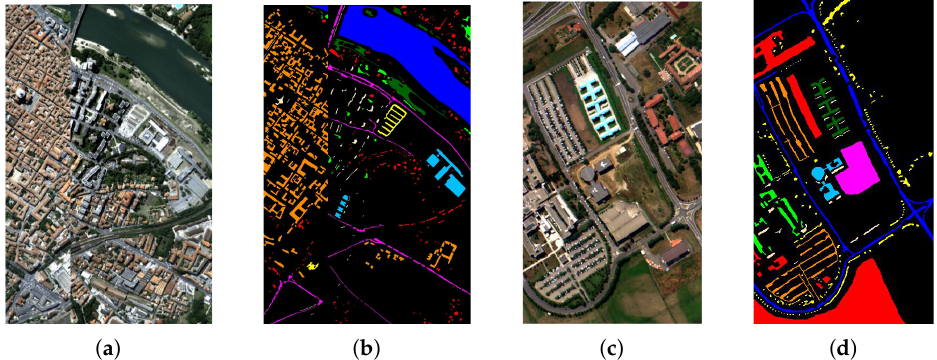
Figure 9. ( a ) The false color image of the Pavia Center dataset [58], ( b ) The corresponding ground- truth map. ( c ) The false color image of the Pavia University dataset [58], ( d ) The corresponding ground-truth